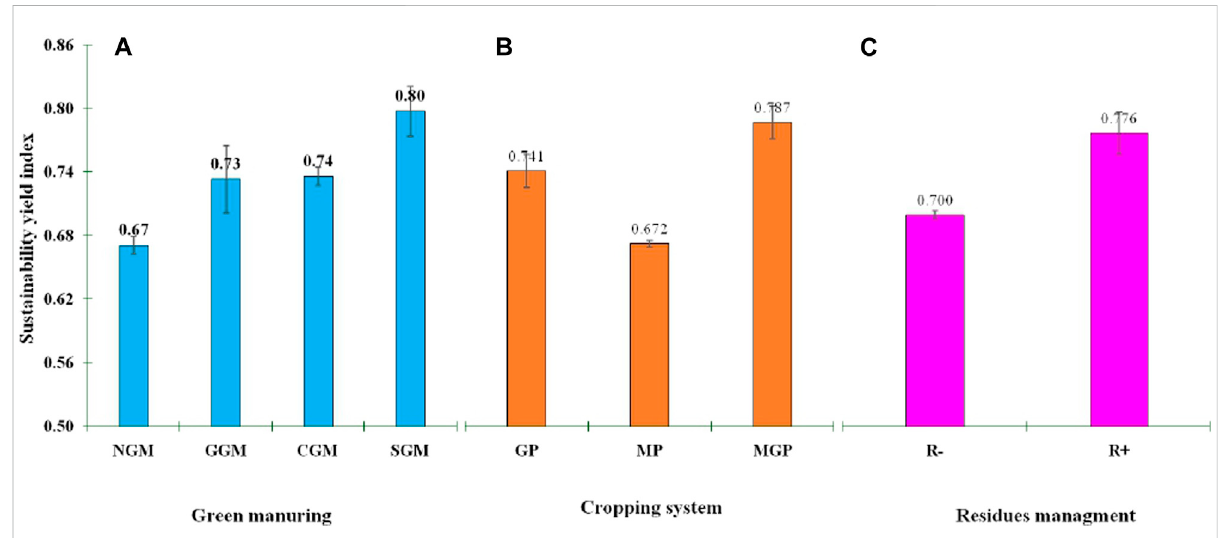
FIGURE 7 Sustainability yield index as in fl uenced by (A) green manuring, (B) cropping systems, (C) residue management NGM: No green manuring, GGM: greengram manuring, CGM: cowpea green manuring, SGM: sesbania green manuring, GP: groundnut – pea, MP: maize – pea, MGP: maize + Groundnut – pea, R-: residue removal, R+: residue retention. The vertical bars represent p < 0.05 signi fi cant